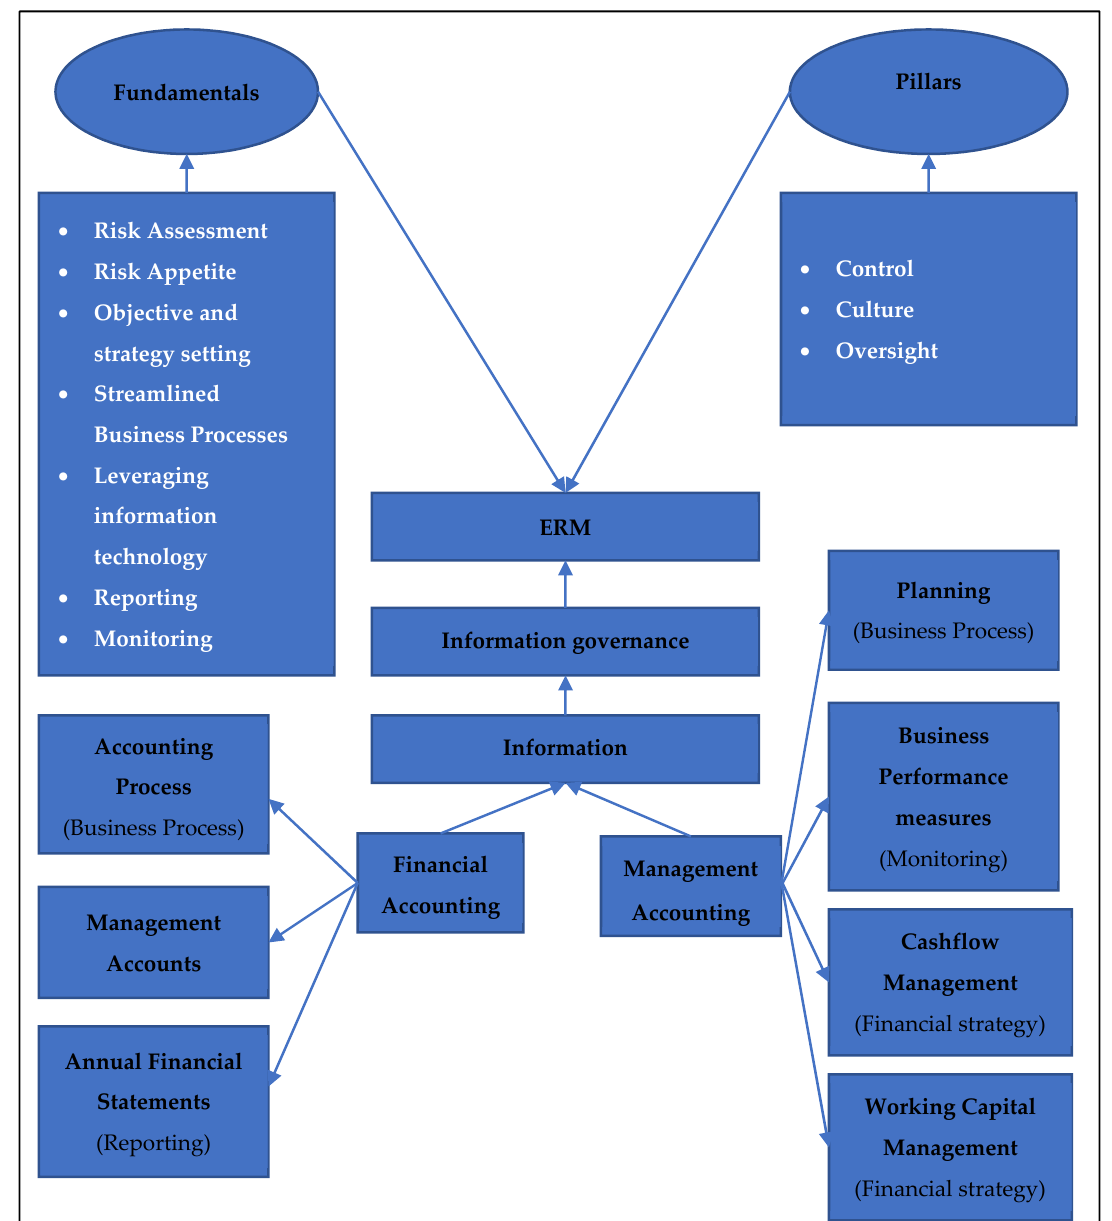
Figure 1. Conceptual SMERMF. Source: Author’s own.